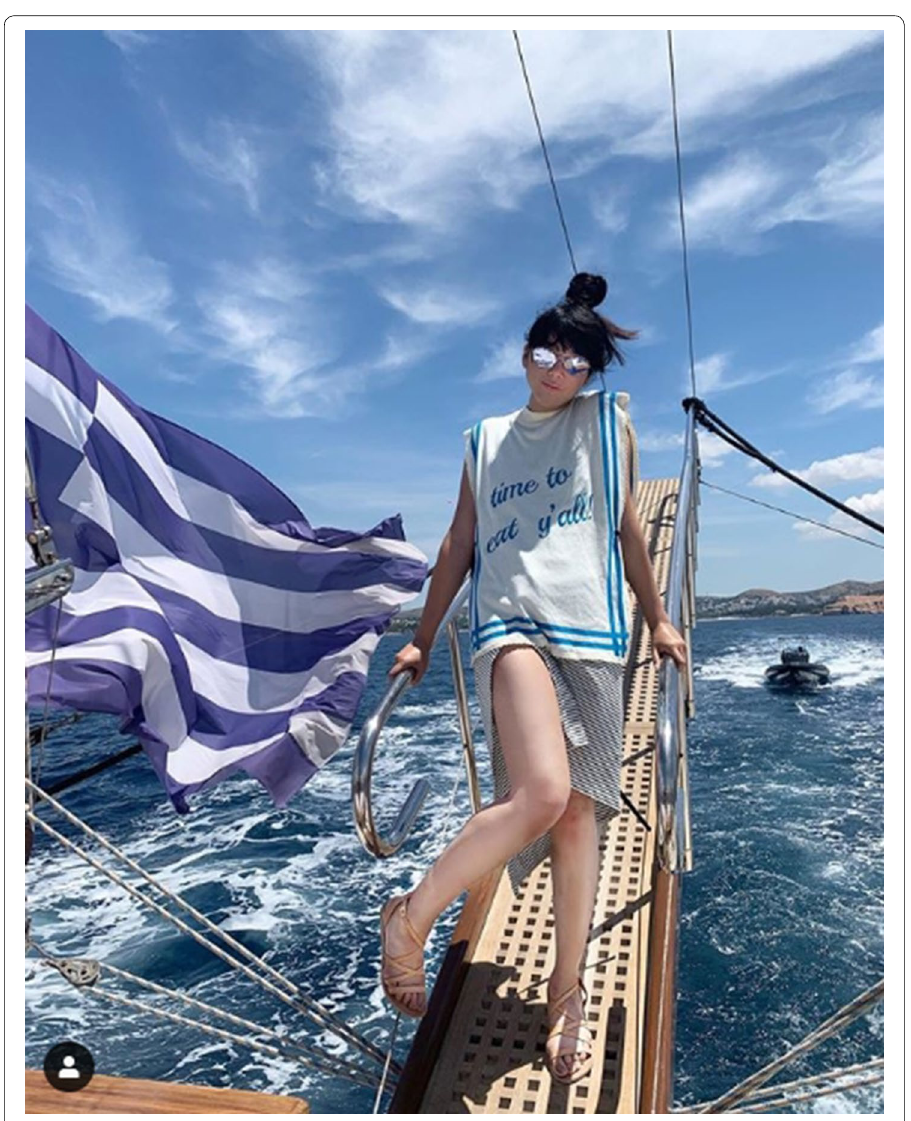
Fig. 3 The perfect Greek sentiment. https ://www.insta gram.com/p/ByNQC 5AAud j/. Accessed 5 September to the industrial era’s limitations of time and space—saturates everyday life. Accord- ingly, the fashion images on Lau’s Instagram depict this blurred line between work and leisure, reflecting the transcendental characteristic of digital space–time. Further- more, Lau portrays this lifestyle, in which work and play coexist beyond the norms of linear time and industrial space, as being characterized by a playful dailiness.